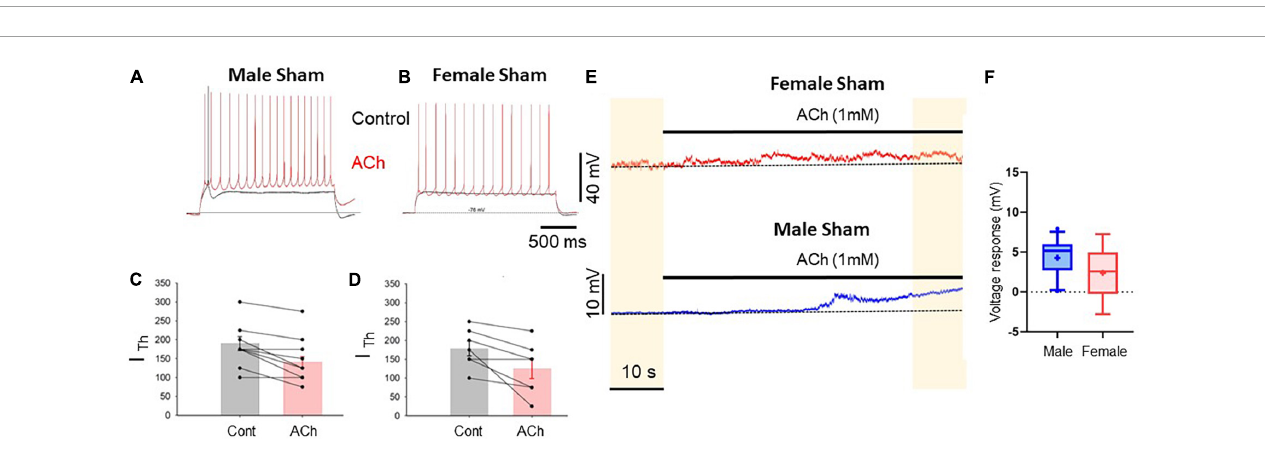
FIGURE2 Prelimbic cortex L5 excitatory cholinergic modulation is similar in pyramidal cells of male and female rats. (A,B) Voltage traces recorded from L5 pyramidal neurons in acute PLC slices in response to depolarizing current injection in control conditions (black traces) and after 1 mM ACh (red traces) in slices from sham male (A) and female (B) rats. The bathing solution contained blockers of fast synaptic transmission (50 µ M picrotoxin and 2.5 mM kynurenic acid). Resting potential was ∼ –75 mV. (C,D) Summary plots showing the reduction in rheobase current caused by acetylcholine in male (C) and female (D) animals; no sexual dimorphism was detected in this response; p = 0.67. (E) Depolarizing responses caused by ACh application (horizontal bar) observed for 1 min in continuous recordings in slice from a female (top trace) and a male (bottom trace). (F) Summary plot representing the average ACh-dependent depolarization calculated comparing the voltage recorded in the first 10 s and the final 10 s of recording (yellow shaded areas). The mean ACh-mediated depolarization was 2.4 ± 1.59 mV in cells from females and 4.3 ± 0.72 mV in cells from males (males vs. females p =